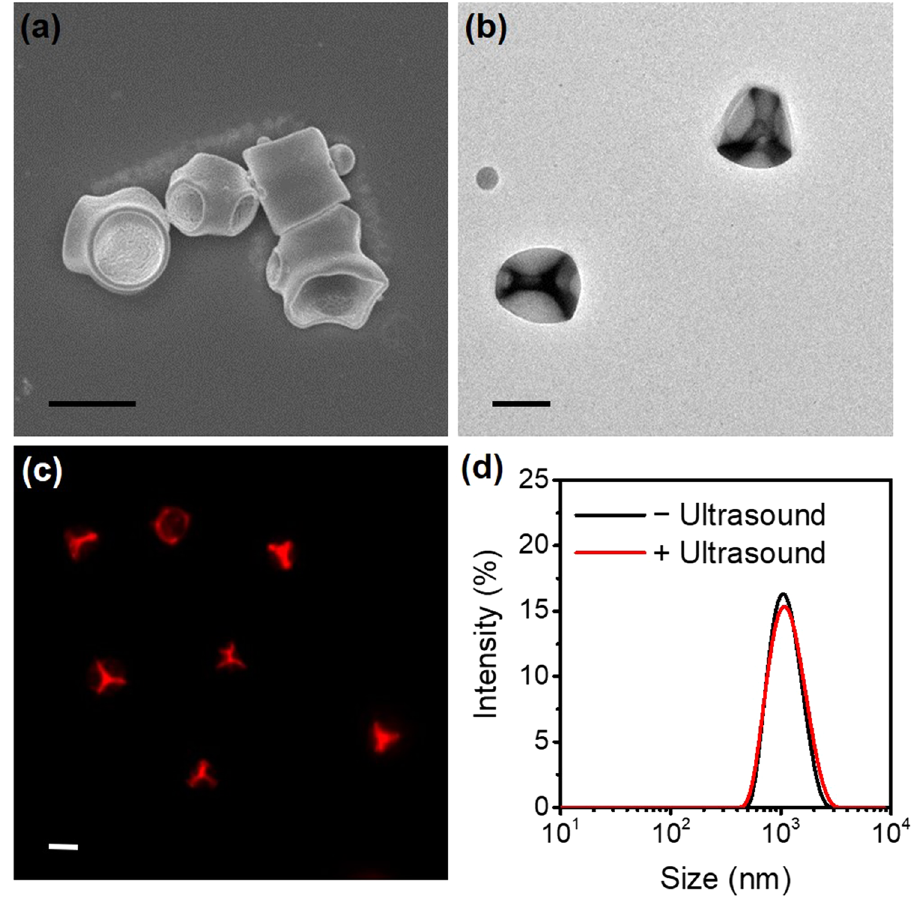
Figure 3. ( a ) Representative SEM, ( b ) TEM, and ( c ) fluorescence images of RhB-mcPLGA MPs. ( d ) Size distributions of RhB-mcPLGA MPs before and after exposure to HIFU. The scale bars represent 1 μ m in ( a – c